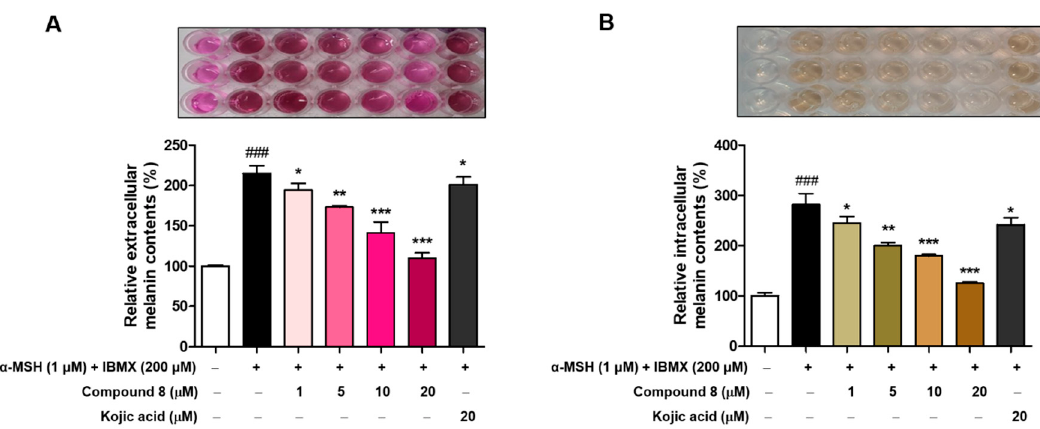
Figure 6. Effects of compound 8 on the melanin contents in B16F10 cells. Cells were pretreated with compound 8 at varied concentrations (1, 5, 10 and 20 µ M) or kojic acid (20 µ M) for 2 h and then stimulated with α -melanocyte-stimulating hormone ( α -MSH) (1 µ M) and 3-isobutyl-1-methylxanthine (IBMX) (200 µ M) for 48 h. Extracellular ( A ) or intracellular ( B ) melanin contents were measured as described in the Methods section. The means ± SEM of three independent experiments are presented. ### p < 0.001 vs. vehicle; * p < 0.05, ** p < 0.01 and *** p < 0.001 vs. α -MSH and IBMX-treated.